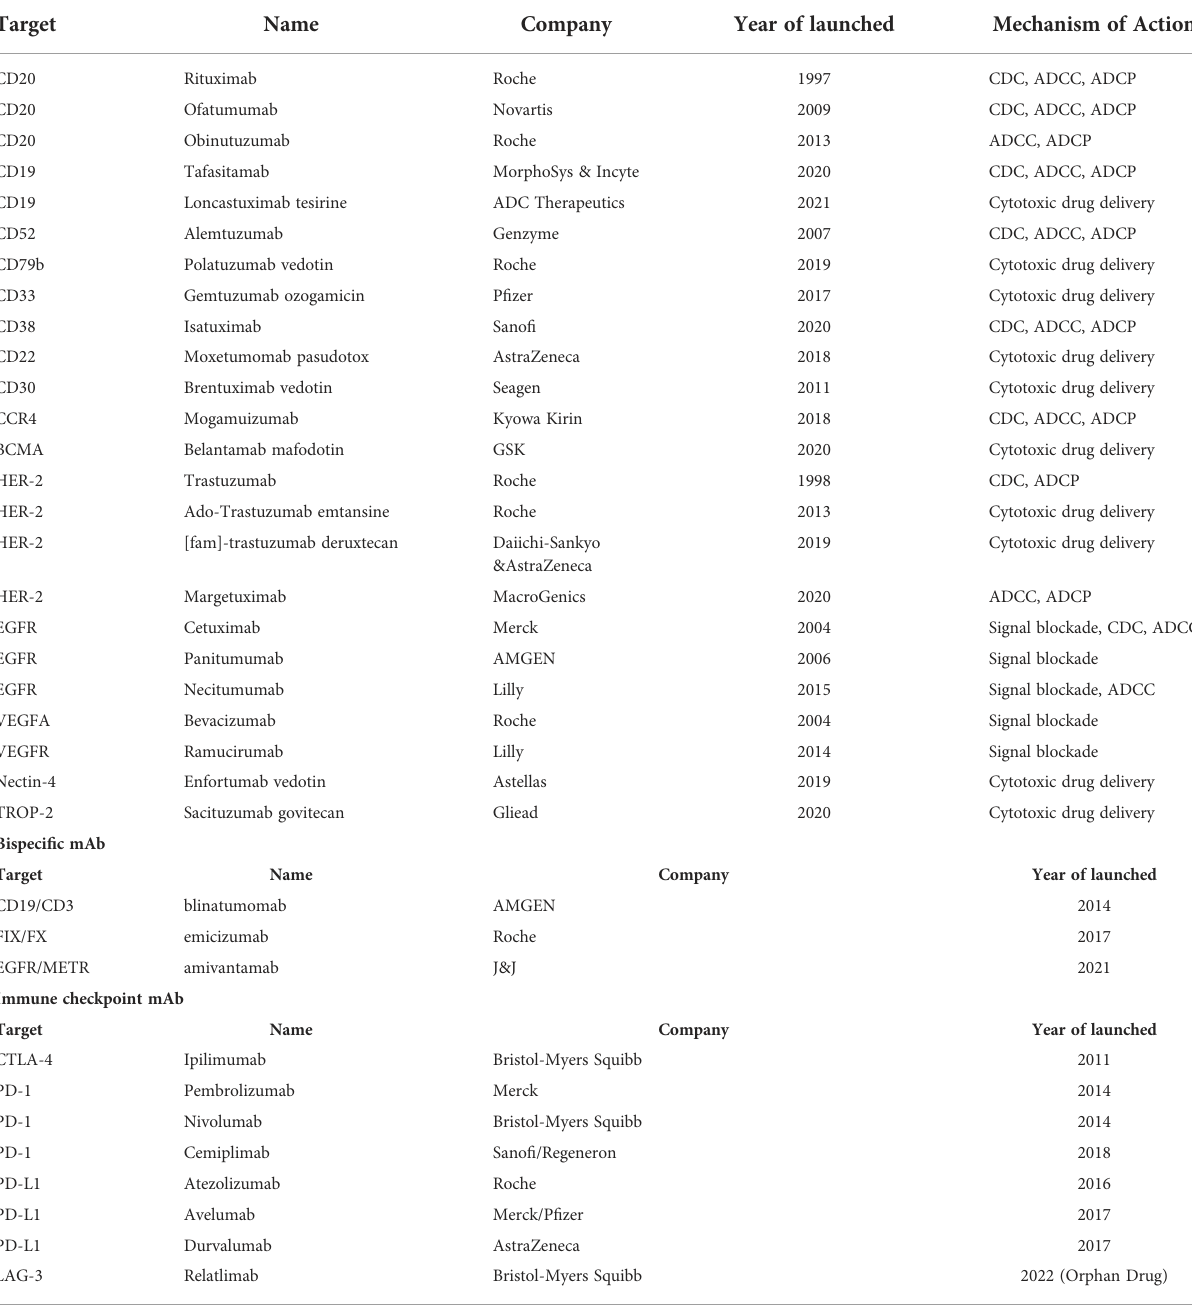
TABLE 1 FDA-approved mAbs (Up to March